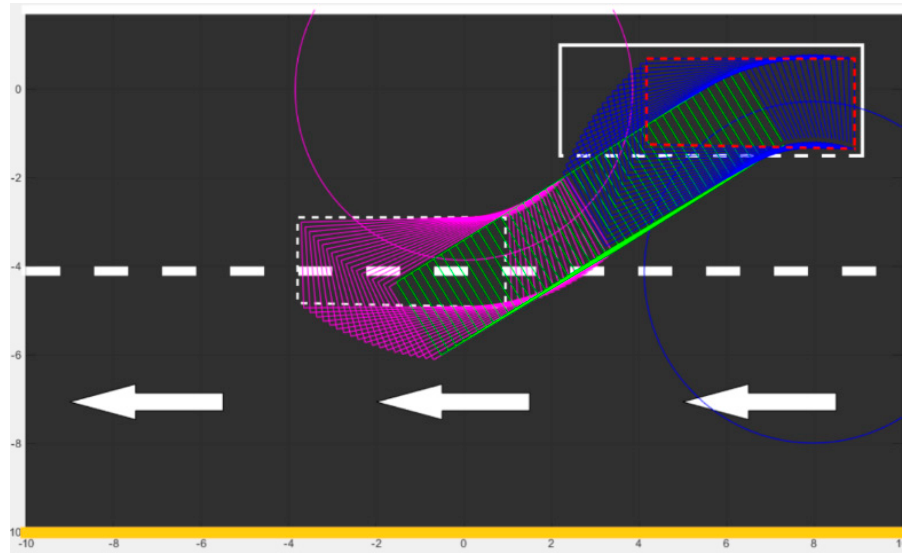
Figure 5. Parallel Parking Path Simulation Result.